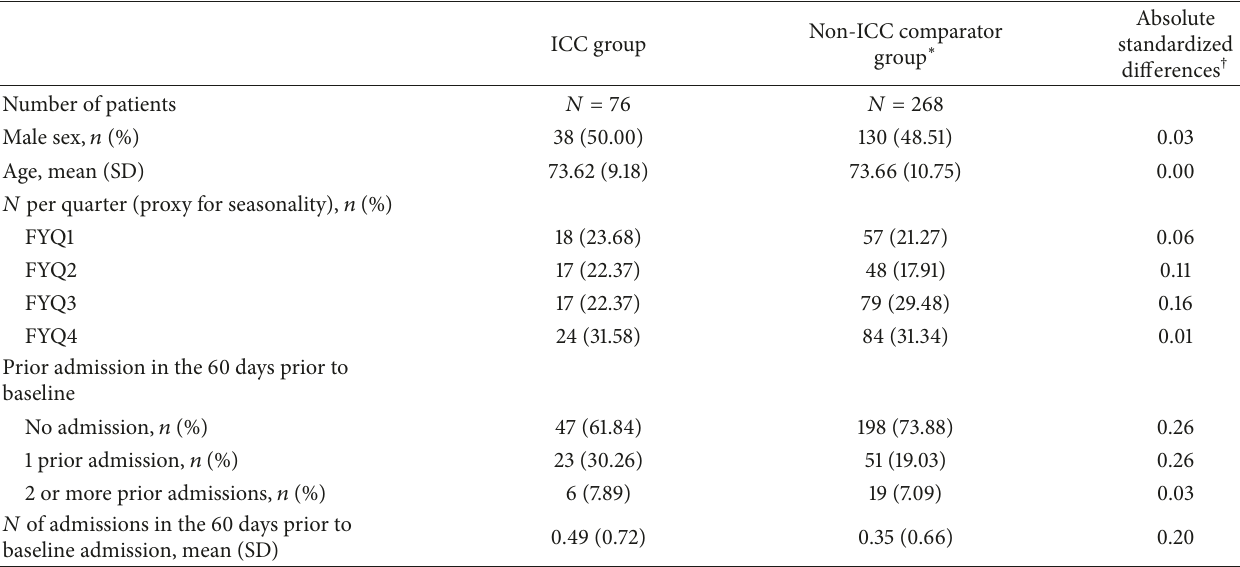
Table 1: Baseline characteristics within the unmatched ICC and eligible COPD patients.